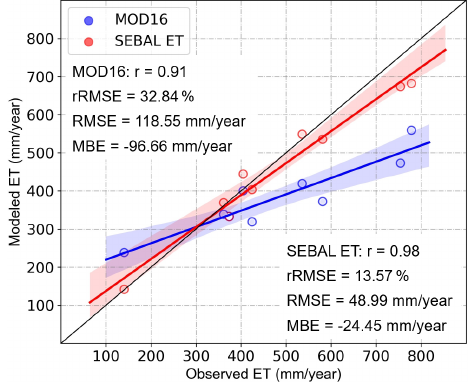
Figure 10. The results of validation at the basin